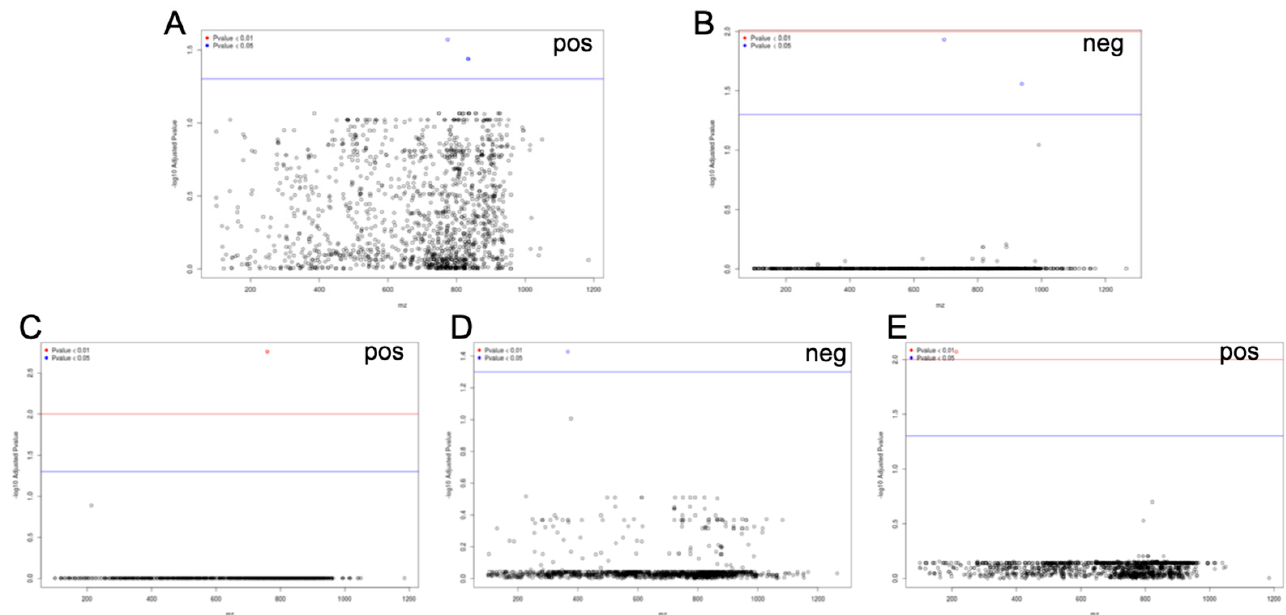
Figure 4. Metabolome-wide association studies (MWAS) in patients with cardiometabolic syndrome. Correlations were tested between clinical and biochemical phenotypes and serum metabolic features characterized by a mass-to-charge ratio (m/z) shown on the x-axes. Data are shown for body-mass index ( A ), family history of hypertension ( B ), total cholesterol ( C ) and HDL cholesterol ( D , E ). The Y -axis corresponds to the adjusted false-discovery rate (FDR). Regression analysis was adjusted for age and sex effects by including them as covariates in the model. pos, positive ionization mode; neg, negative ionization mode. Table 4. Significant associations between lipidomic features and clinical and biochemical pheno- types in the study group. Lipidomic features were independently acquired in negative- and posi- tive-ionization modes in serum samples from a study group of 273 individuals. Linear regression was used to compute a P-value statistic for each metabolic feature, which was corrected for multiple testing using the Benjamini-Hochberg method to calculate adjusted p -values. Significant evidence of association was obtained for cardiometabolic disease (CMD), family history (FH) of hypertension, body-mass index (BMI) and total and HDL cholesterol. CMD was assessed by presence of at least three anomalies (diabetes, hypertension, BMI > 30kg/m 2 , HDL < 40mg/dl). Results from association analysis for all phenotypes that did not reach statistical significance following correction for multi- ple testing (nominal p -value < 0.05) are shown in Supplementary Table S3. Mass-to-charge ratio (m/z) and retention time (RT) are reported for each lipidome feature. Assignment of lipid candidates for lipidome features was performed using LIPID MAPS (https://www.lipidmaps.org, accessed 01